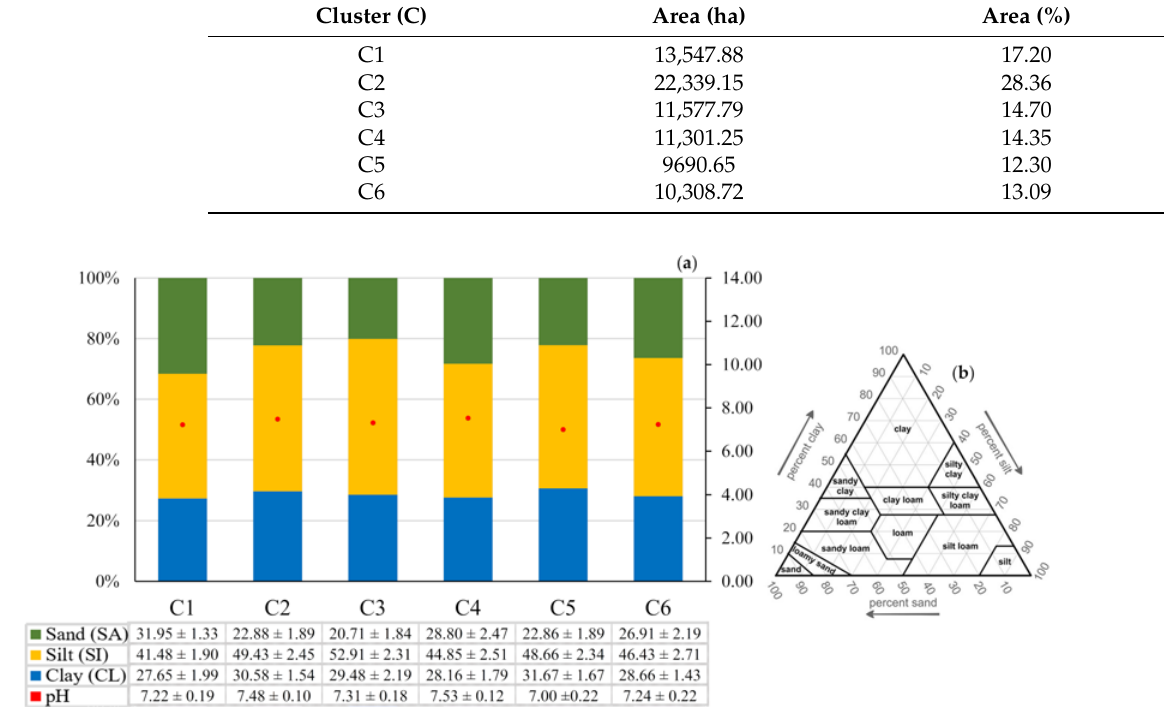
Figure 11. Characterization and pedological classification of soils: ( a ) pedological parameters, namely, sand ( SA ), silt ( SI ), clay ( CL ), and pH ( pH ) of the 6 clusters from k-means; and ( b ) USDA soil texture triangle useful for soil classification.